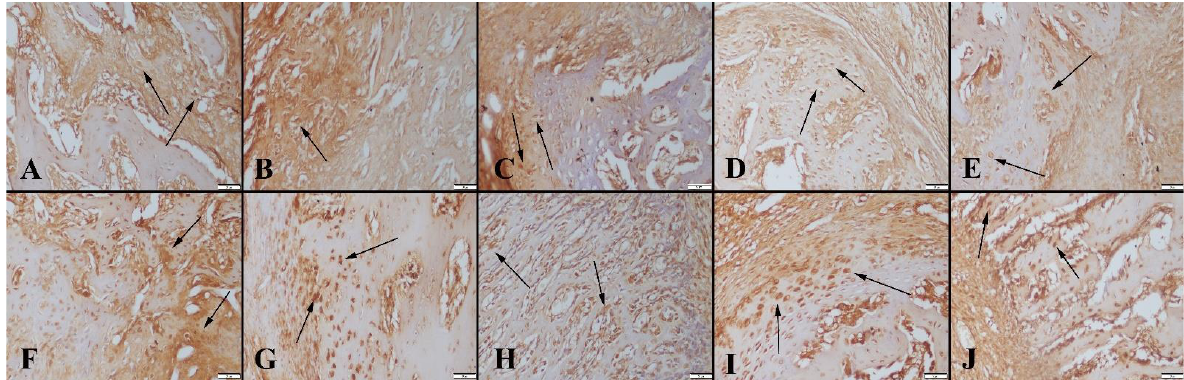
Figure 11. ALP expressions between the groups. ( A ) Control group, ( B ) Group 1, ( C ) Group 2, ( D ) Group 3 and ( E ) Group 4, for 4-week and ( F ) Control group, ( G ) Group 1, ( H ) Group 2, ( I ) Group 3 and ( J ) Group 4, for 8-week, arrows indicate immunopositive cells. Streptavidin bi- otin peroxidase method, scale bars = 50 µ